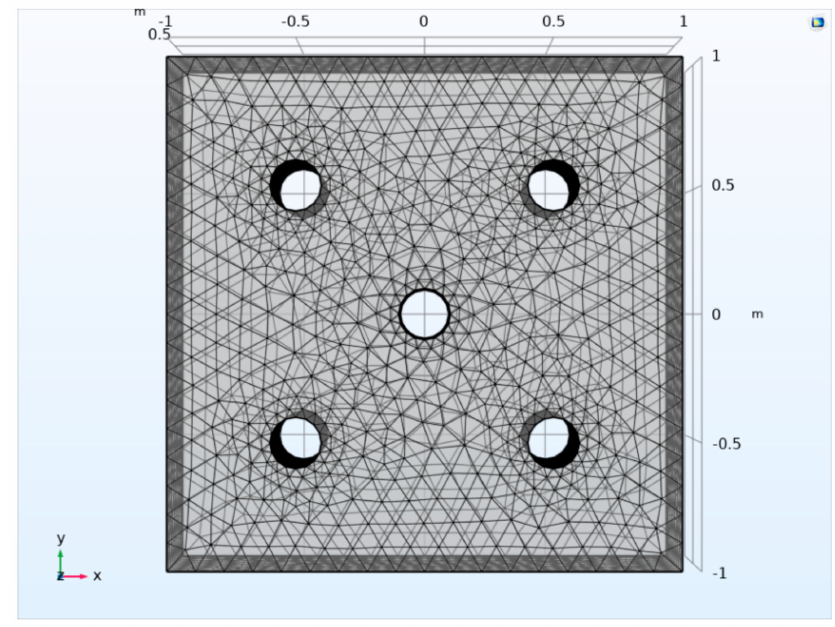
Figure 4. Grid division of Darcy’s law simulation